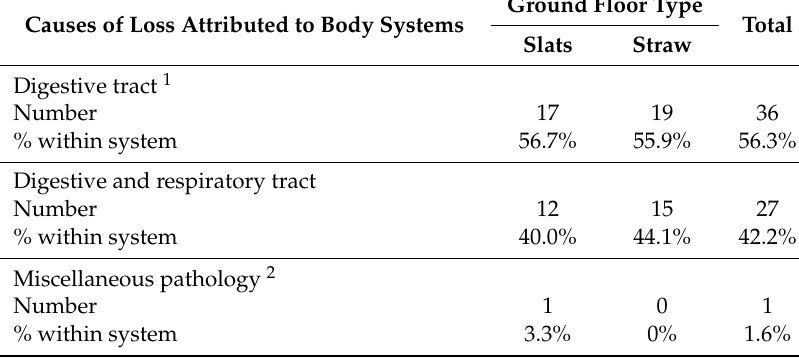
Table 3. Causes of loss, i.e., main pathological findings, of animals reared in pens with the ground floor consisting of slatted plastic panels (Slats, n = 30) or pens with the ground floor consisting of concrete littered with straw (Straw, n = 34) according to necropsy diagnoses—number and percentage of animals attributed to body systems. No relationship between ground floor type and causes of loss was found ( χ 2 = 1.20; df = 2; p = 0.55).